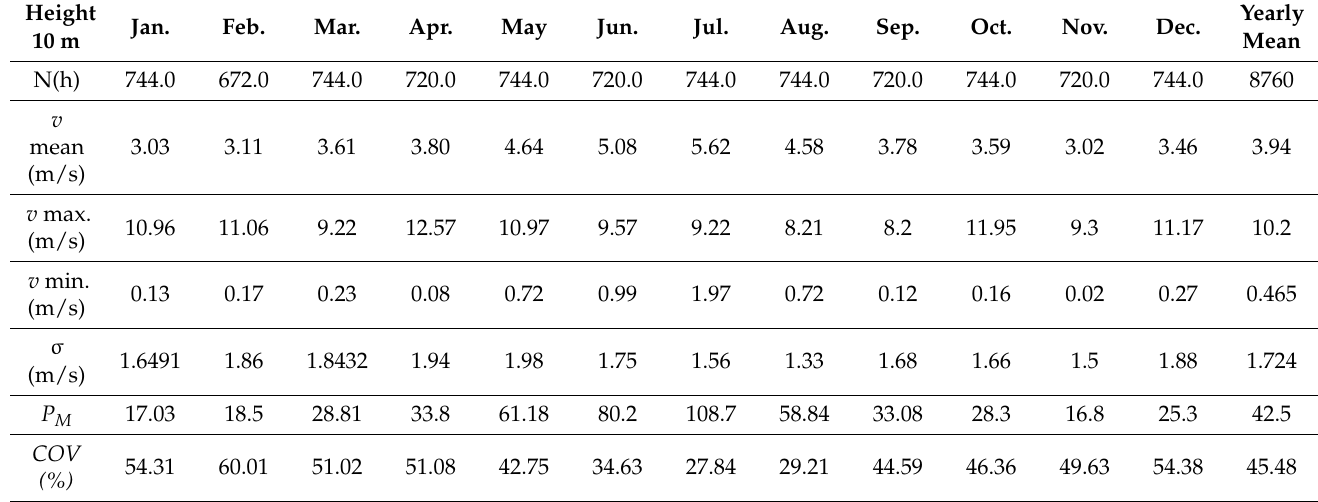
Table 3. The monthly of mean wind speed in (m/s) data for selected wind station at 10 m height. ( COV ) coefficient of variation during the period